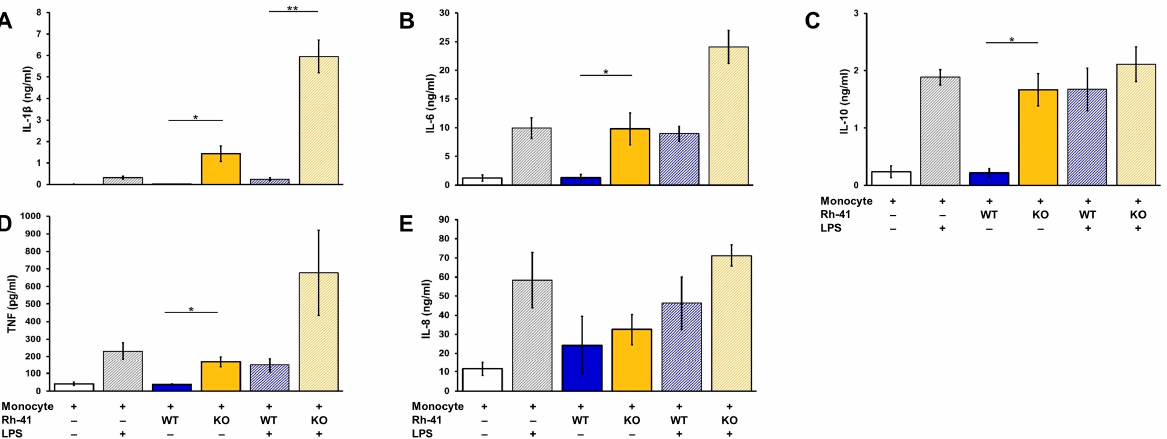
Figure 3. Chemerin regulates cytokine secretion in RMS cell monocyte cocultures. A total of 6 × 10 5 monocytes, resting or activated with 100 ng/mL LPS, were cocultured with 2 × 10 5 parental (WT) or chemerin-deficient (KO) Rh41 cells. After 48 h levels of IL-1beta ( A ), IL-6 ( B ), IL-10 ( C ), TNF ( D ) and IL-8 ( E ) in coculture, supernatants were determined by ELISA. Depicted are means ± standard error of measurements of monocytes from 4 different donors. * p < 0.05, ** p < 0.01, as determined by paired Student’s t -test.